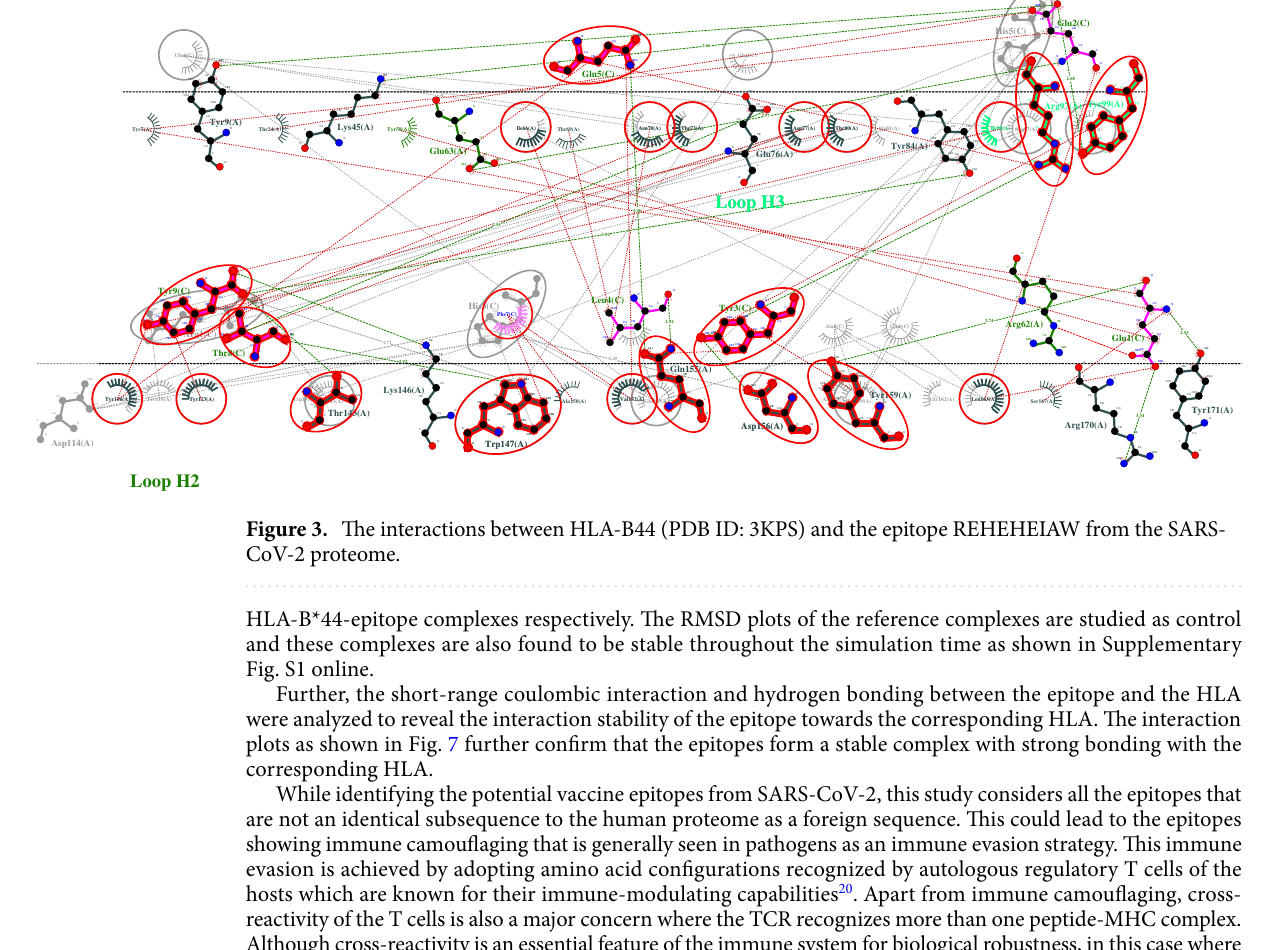
Fig. S1 online. Further, the short-range coulombic interaction and hydrogen bonding between the epitope and the HLA